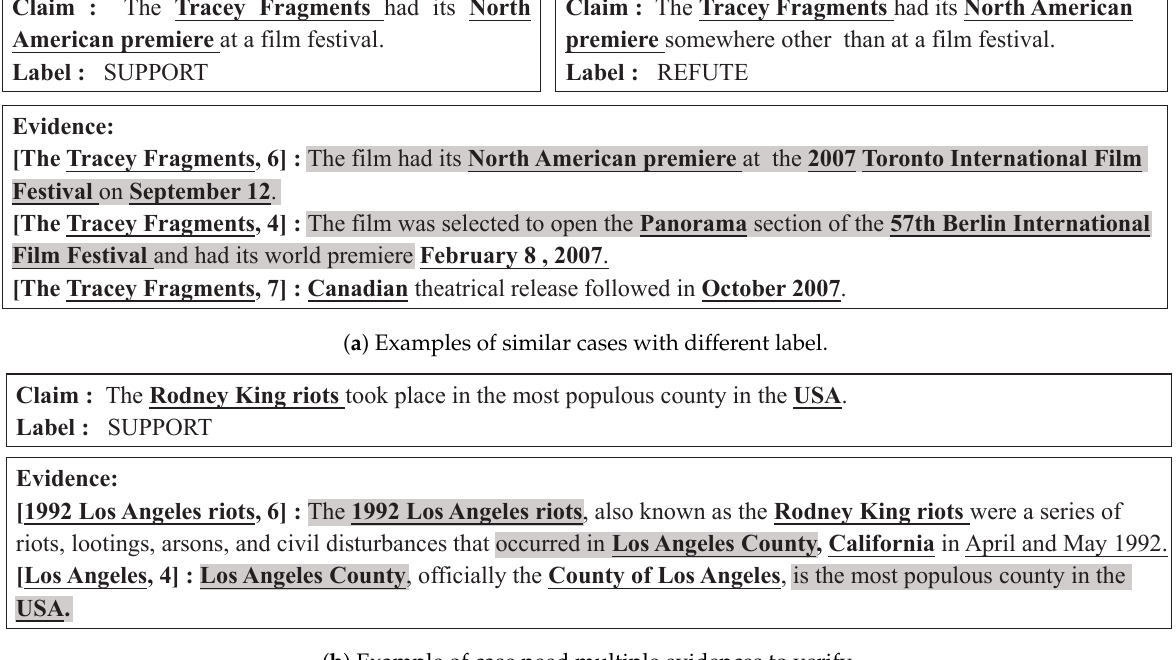
Figure 1. Examples of fact verification. The key evidences to verify the claims are highlighted, and the bold tokens denote the key entity in the cases. [Docname, linenum] indicates the evidence is extracted from line “linenum” in article